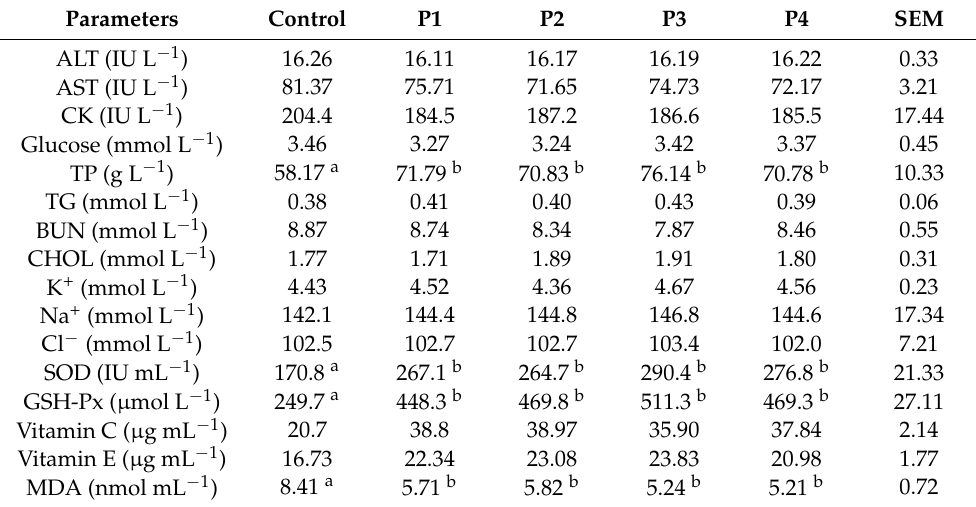
Table 4. Blood biochemical parameters of goats fed probiotics in hot